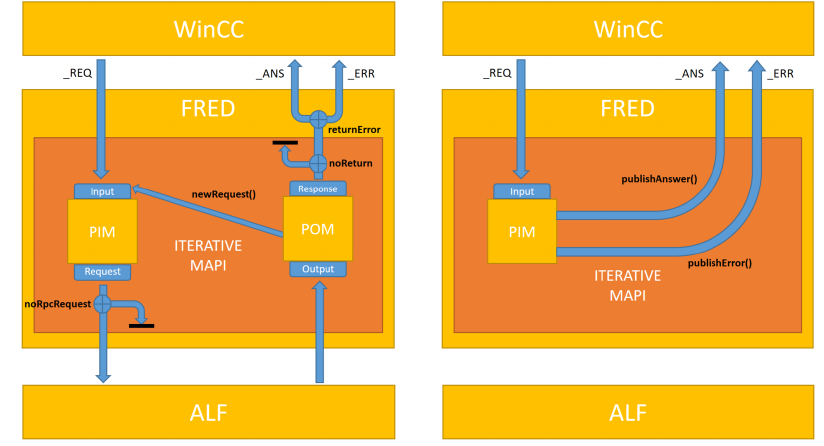
Figure 6. Functional diagram of the Iterative Message Application Interface